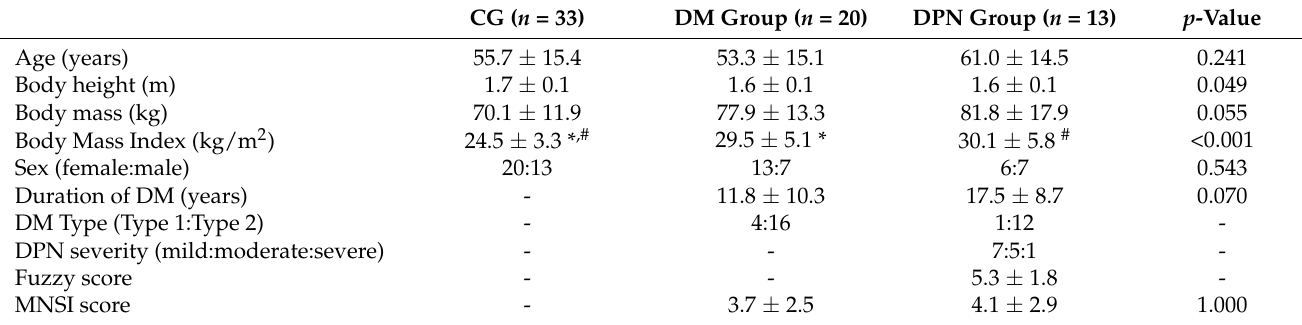
Table 1. Anthropometric, demographic, and clinical characteristics of the control group (CG), DM group, and DPN